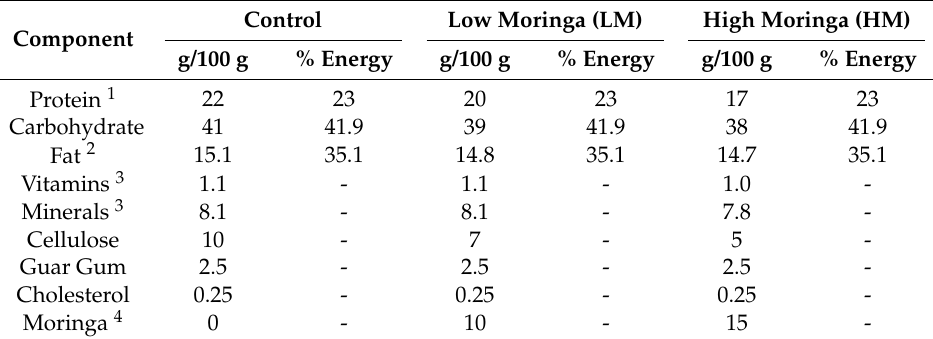
Table 6. Composition of experimental